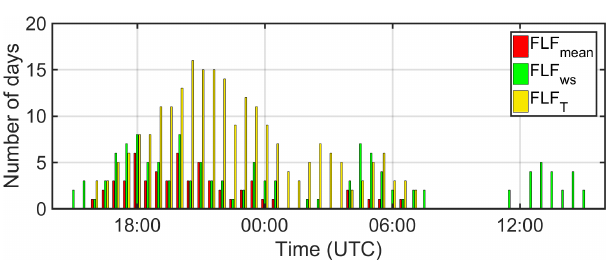
(Fig. 7): the stronger the monsoon flow strength in the af- ternoon between 12:00 and 15:00 UTC, the earlier the MI arrival time. The absolute value of the correlation coefficient between both is 0.61. The two exceptionally early arrivals at 16:00 and 16:30 UTC shown in Fig. 7 and put in Table 1 are associated with unusually strong monsoon flow all day long (e.g., the nights of 10–11 and 11–12 July). The NLLJ onset and breakup cannot be detected prior to 17:00 UTC and after 08:00 UTC, respectively, because of